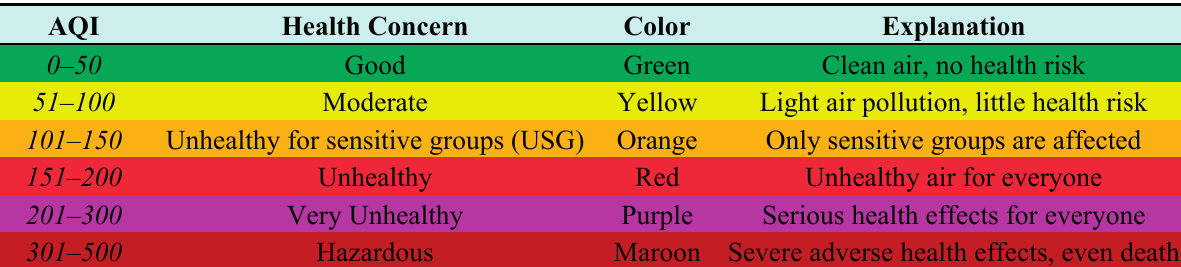
Table 1. The U.S. AQI standard (Source: EPA